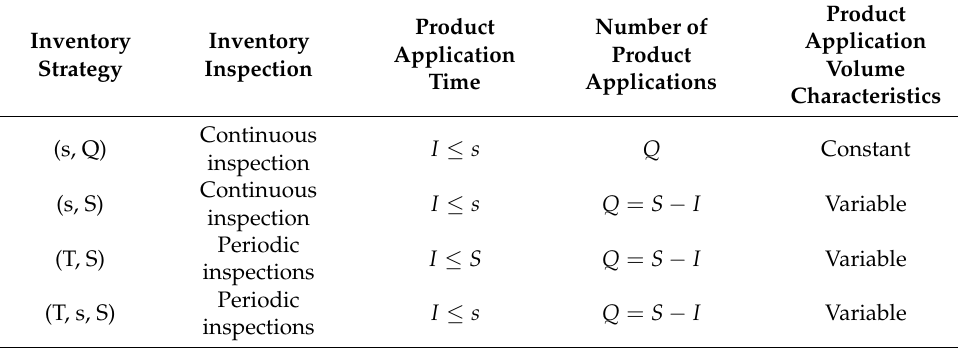
Table 1. Comparison of inventory control